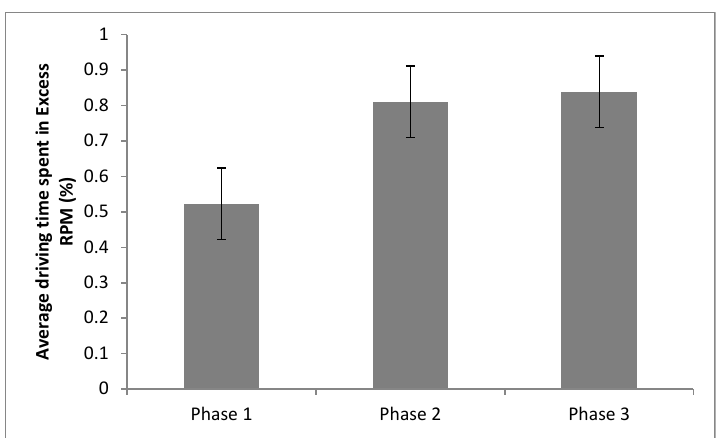
Figure 6. Average percentage of driving time in Excess